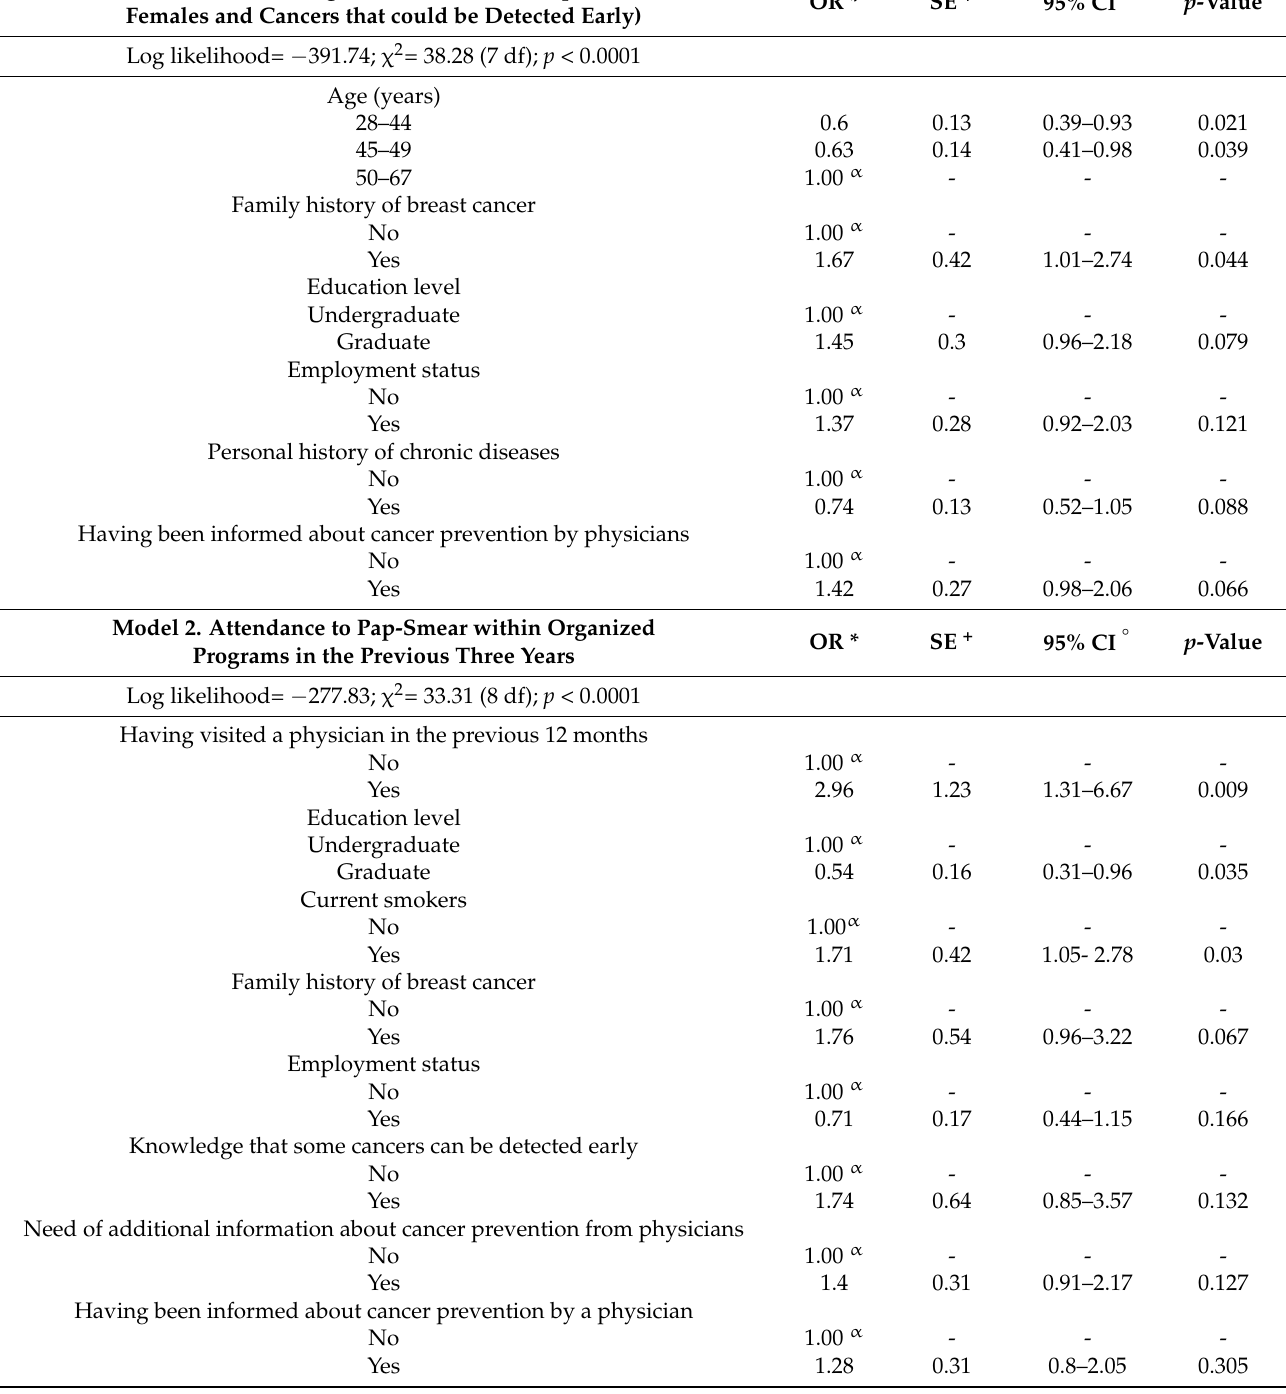
Table 2. Logistic regression models results. Model 1. Accurate Knowledge (about the Most Frequent Cancers in Females and Cancers that could be Detected